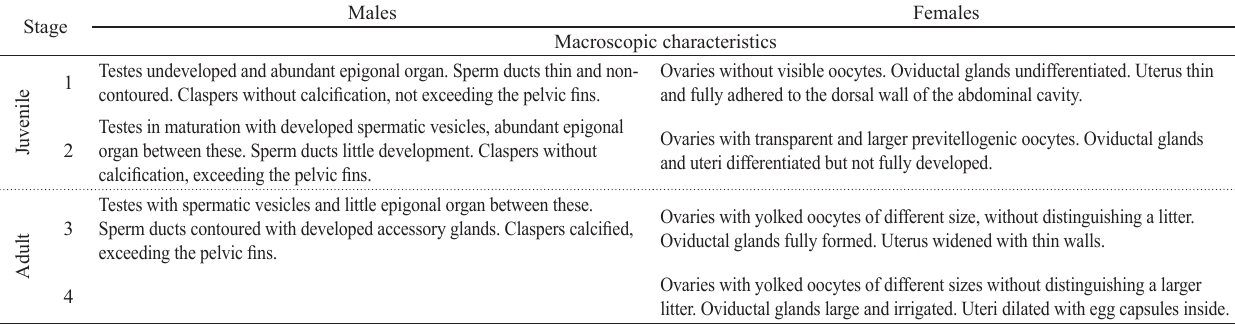
Fig. 1 . Map of the study area showing trawl stations carried out in research cruises during 2002 and 2007 (dark dots) and the commercial capture (dark statistical rectangles of 1 degree by 1 degree) where Atlantoraja cyclophora were collected. Tab. 1 . Morphological criteria used to determine macroscopically the stage of sexual maturity of males and females Atlantoraja cyclophora . Criteria adapted from Colonello